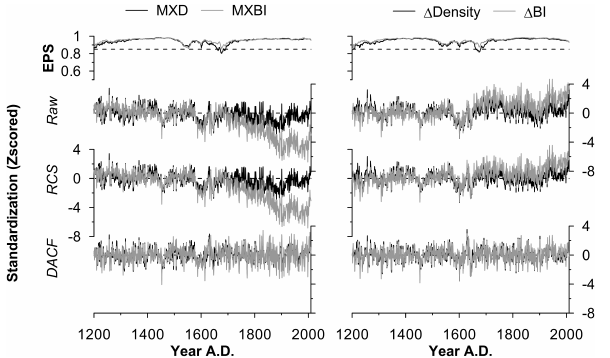
Figure 4. MXD, MXBI and Δ Density and Δ BI chronologies with expressed population signal (EPS). Raw chronologies are averaged without standardization and RCS chronologies have been developed using a single regional curve, allowing indices to have different means but still being able to represent climatic differences without general age-effects (Briffa et al., 1992). DACF chronologies are standardized with data-adaptive curve fits using time varying response smoothing described in Melvin et al., (2007). The DACF removes mean differences between the resulting indices and is also able to remove more non-climatological variability within each sample.